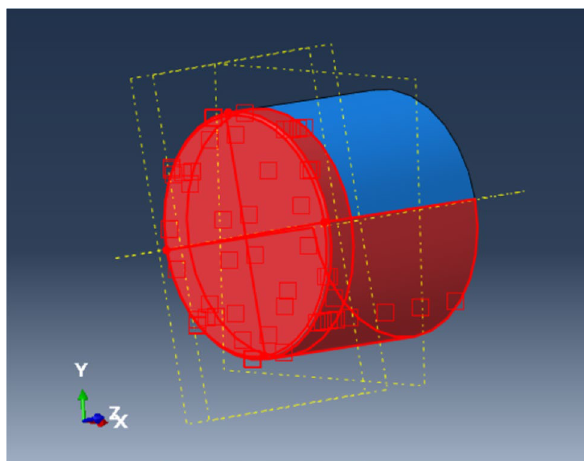
Fig. 3 Interaction surface of the conventional